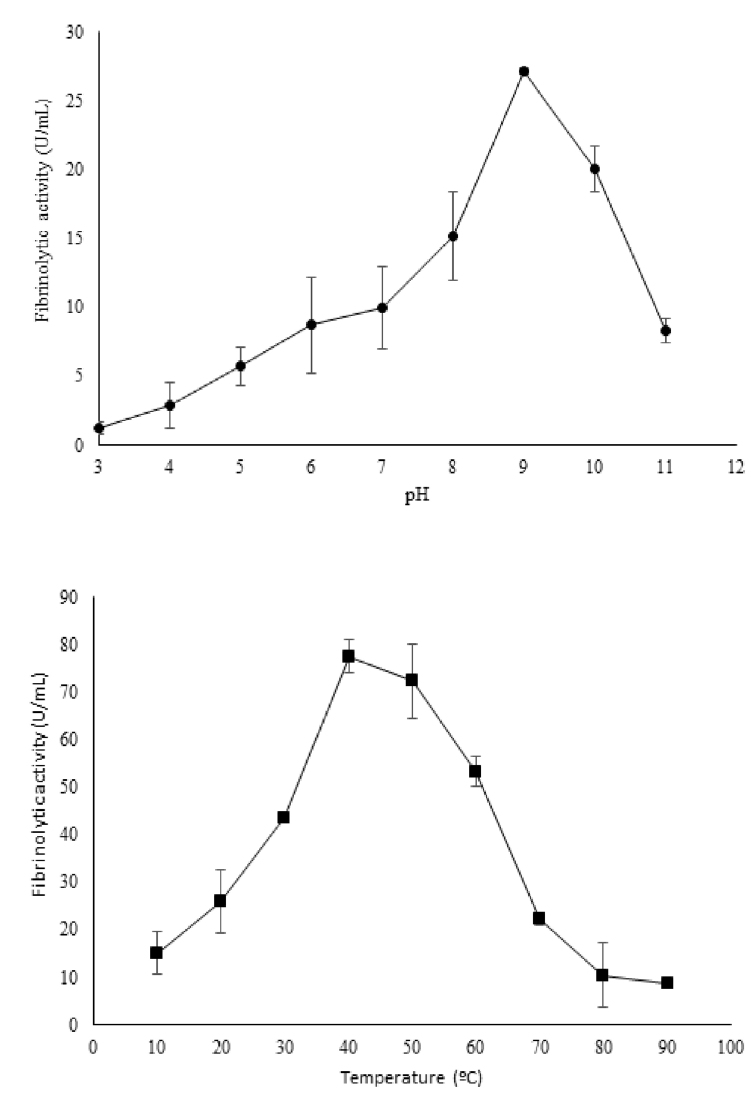
Figure 3. Optimum temperature (a) and optimum pH (b) on fibrinolytic activity of Mucor subtilissimus UCP 1262 of after gel filtrated through Superdex 75